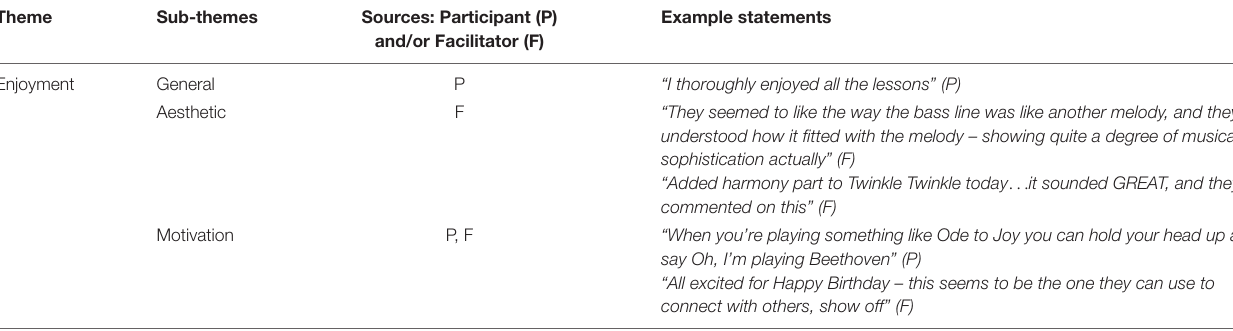
TABLE 2 | Sub-themes and example statements from theme of Enjoyment .